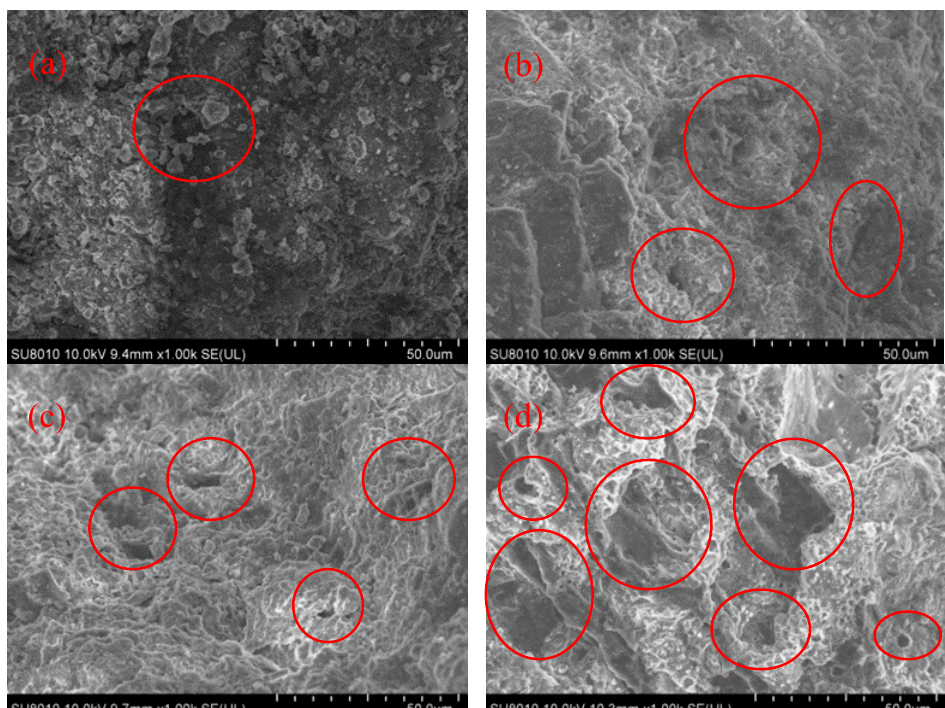
Figure 8. SEM images of the raw and treated shale samples: ( a ) Raw sample S-0 ( b ) Sample S-1 ( c ) Sample S-3 ( d ) Sample S-4.